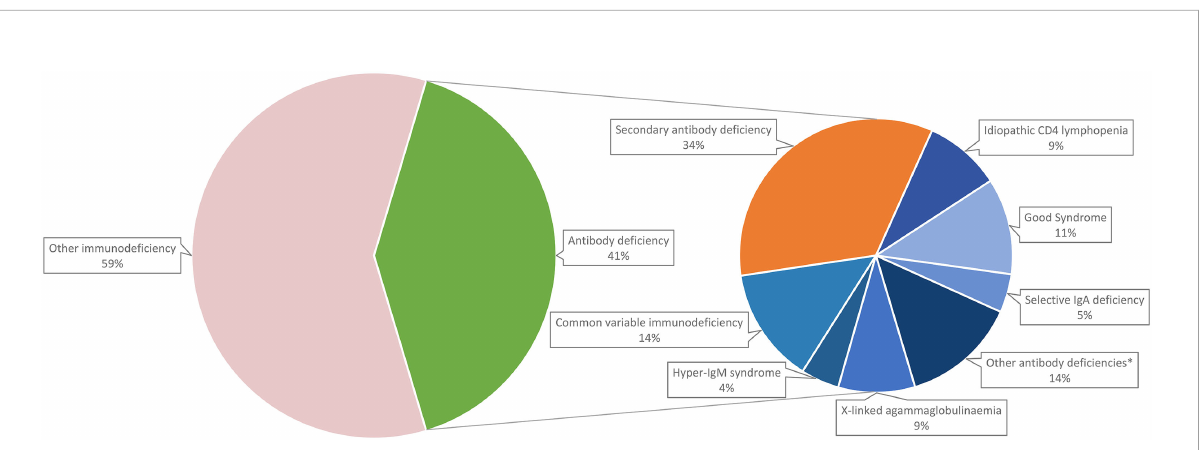
FIGURE 3 Breakdown of adult immunode fi ciency patients in Hong Kong. *Other antibody de fi ciencies include speci fi c antibody de fi ciency (2.3%), late- onset combined immunode fi ciency (2.3%), ADA de fi ciency (2.3%), Wiskott-Aldrich syndrome (2.3%), chromosome 22q11.2 deletion syndrome (2.3%) and X-linked immunode fi ciency with magnesium defect, Epstein-Barr virus (EBV) infection, and neoplasia (2.3%).